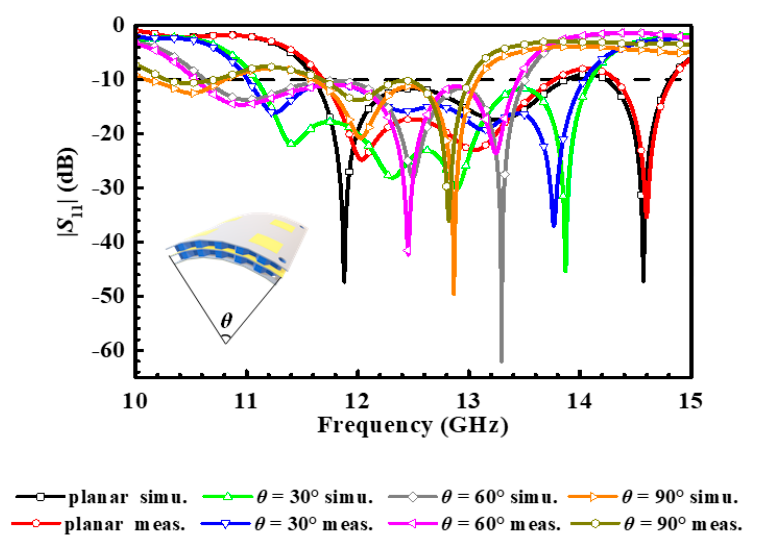
Figure 15. The photograph of the proposed antenna array: ( a ) measurement environment, ( b ) top layer with radiation patches, ( c ) the ground with coupling apertures on the middle layer, ( d ) the feeding network with Wilkinson power divider and ground with four coupling apertures on the middle layer, and ( e ) reflection surface on the back surface of the lower substrate layer.